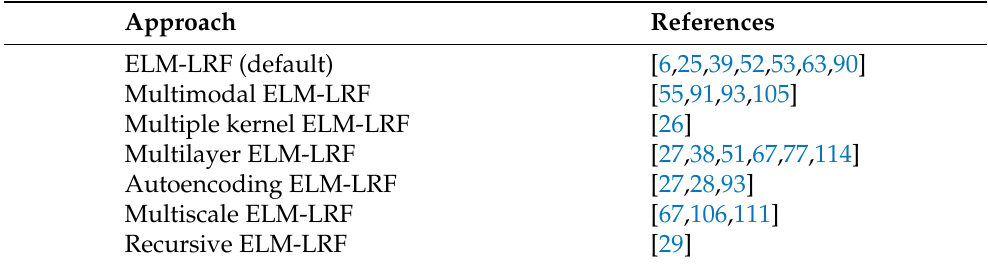
Table 10. Variations for ELM-LRF reported in the primary